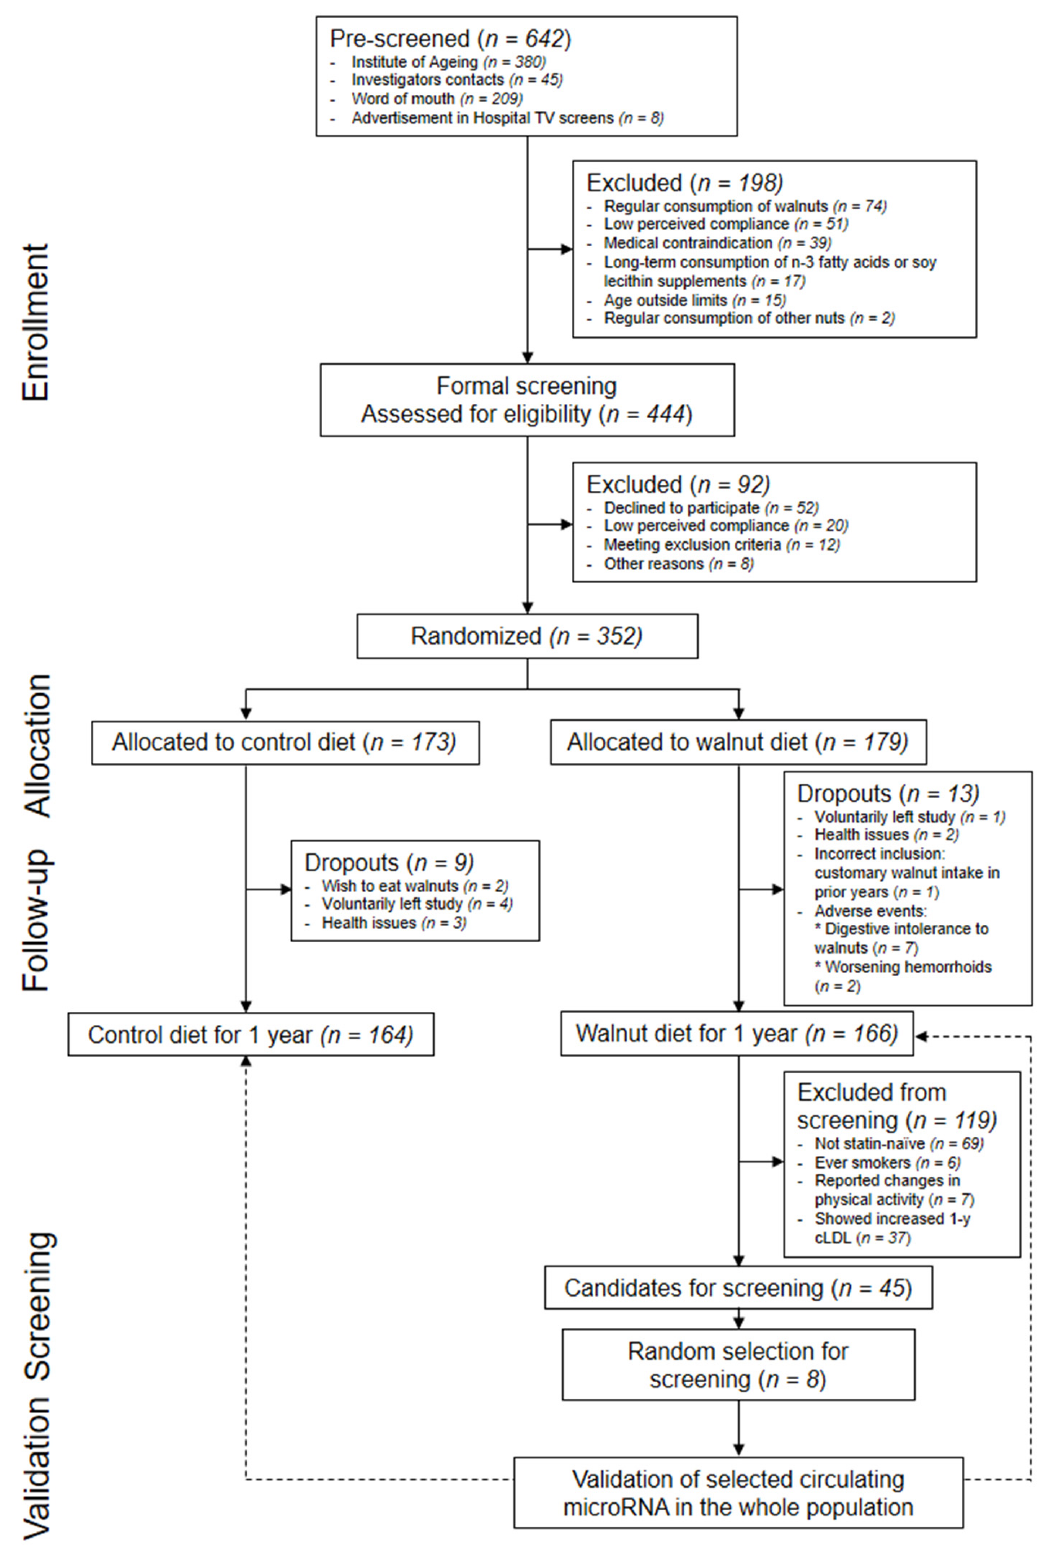
Figure 1. Flow chart of the study. Screening of c-miRNA profiles was performed in 200 µ L of serum samples (before and after intervention) of 8 randomly selected participants from the walnut arm showing any LDL-c reduction after intervention. We extracted c-miRNAs using the